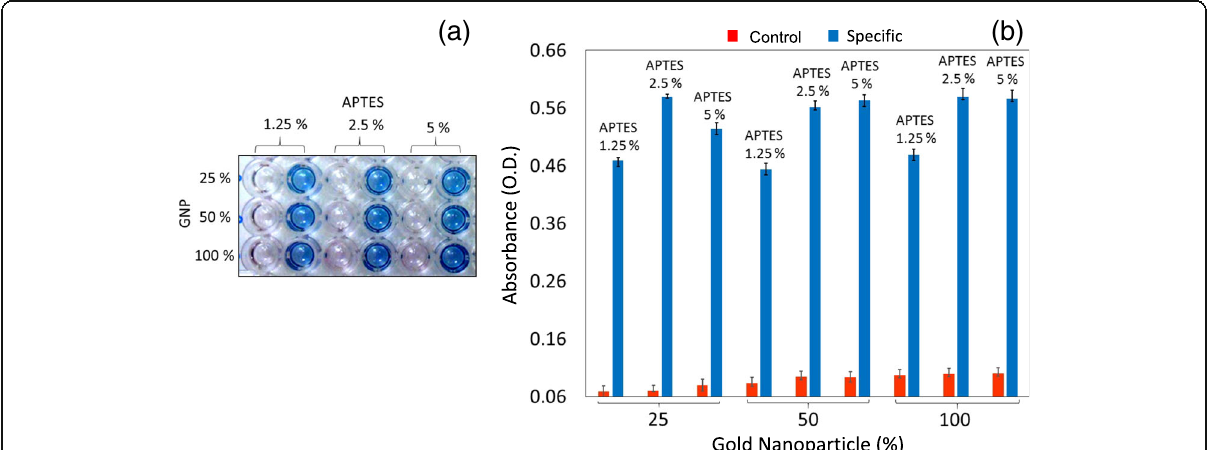
Fig. 3 Determining the amounts of APTES and GNP. Three different concentrations (1.25, 2.5, and 5%) of APTES were used with three dilutions of GNP (25, 50, and 100%). a Visual detection of FIX after adding the substrate. Control lanes without FIX were included. b Graphical representation of the optimum APTES level. 2.5% APTES and 25% GNP were found to be optimal